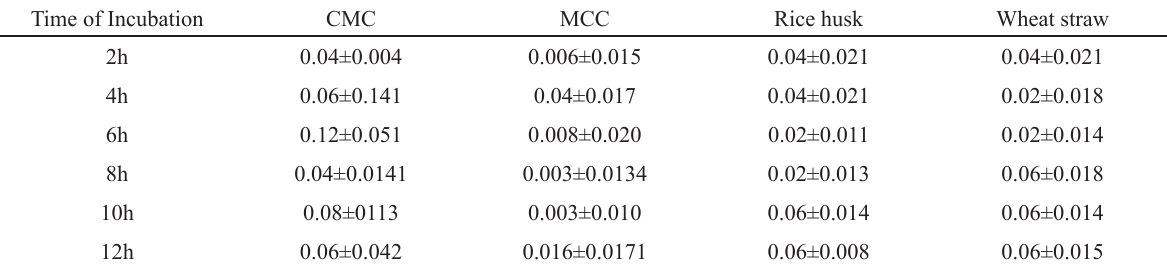
Enzyme activity (UEA mL -1 min -1 ) for isolate 380 under submerged culture supplemented with carboxymethyl cellulose (CMC), microcrystalline cellulose (MMC), rice husk and wheat straw, at 50°C of